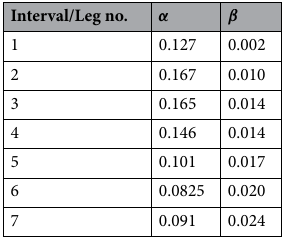
Table 2. Values of α (t) and β (t) for various intervals for making the curve fit with the respective data sets.